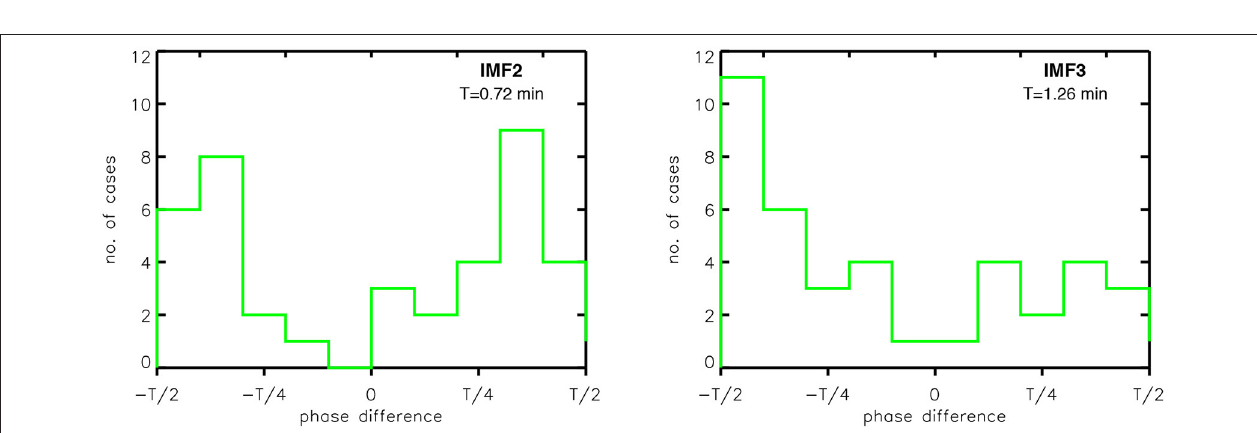
FIGURE 8 | Histograms showing the distribution of periods of the first four IMFs of total intensity in red and Doppler velocity in blue for the 40 selected cases.